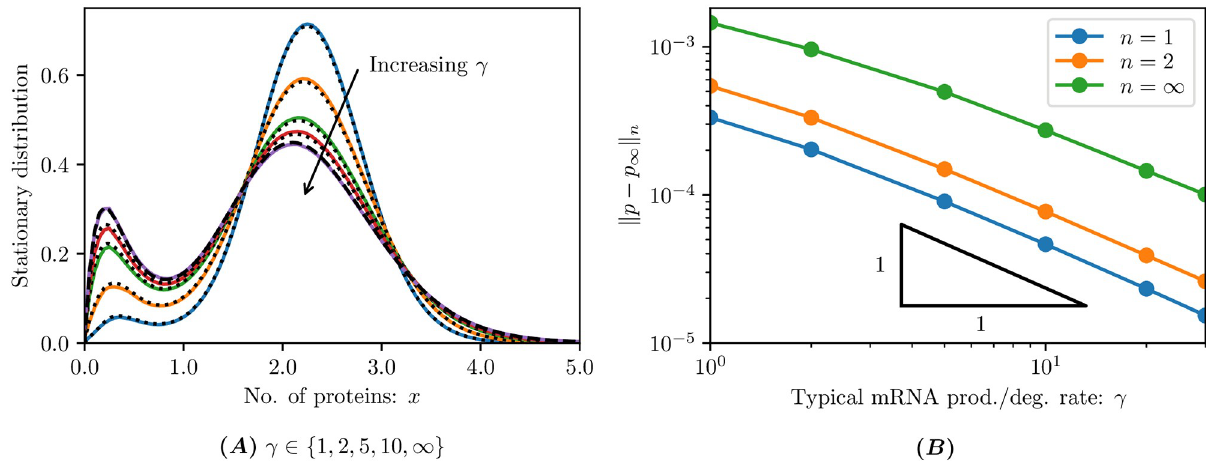
Fig 3. Comparison of self-regulated gene expression models. The stationary distributions of models (6) and (7) are compared while varying the typical mRNA production/degradation rate γ . (A) For finite γ , the solid curves show steady-state solutions of the continuum ACME form (8) compared to dotted curves which are the steady-state solution of the associated discrete CME system, retaining K = 30 discrete mRNA states in both cases. For the limiting case γ = 1 , the solid curve depicts the steady-state solution of the continuum ACME form (10) compared to the dashed curve which is the exact continuum solution p 1 in (12). The distributions are the marginal distributions of protein molecules, summing over the mRNA distribution. All continuum simulations used Δ x = 0.05, corresponding to lumping 10 discrete states together. (B) Convergence of the steady-state solution of the continuum ACME form (8) to the exact continuum solution p 1 in (12) in different L n norms. The triangle shows the 1/ γ convergence rate. We employed a discretisation of Δ x = 0.025, corresponding to lumping 5 discrete states together.